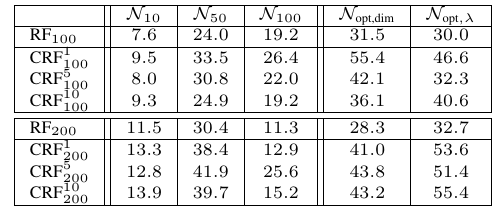
Table 3. Quality q [%] for class p / t achieved in all experiments.